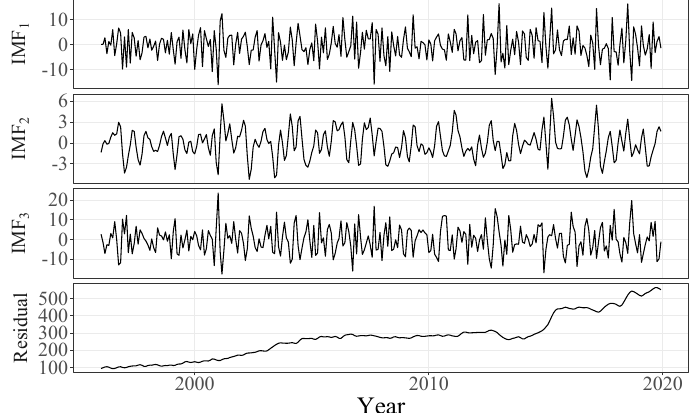
Figure 4. Decomposed series for commercial prices.